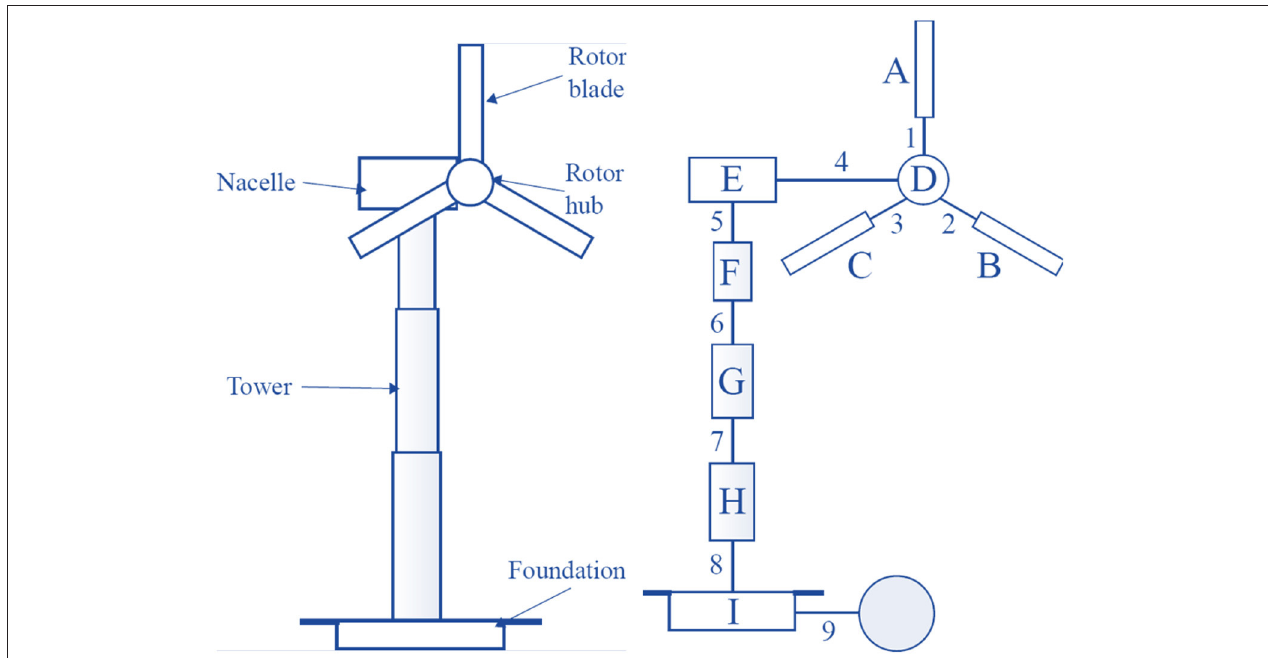
FIGURE 8 | An expanded IE representation of a wind turbine with the elements labeled A to I and the connections labeled 1–9. The shaded node is a special element representing the ground, where the boundary condition is defined in the attributes for Joint 9.